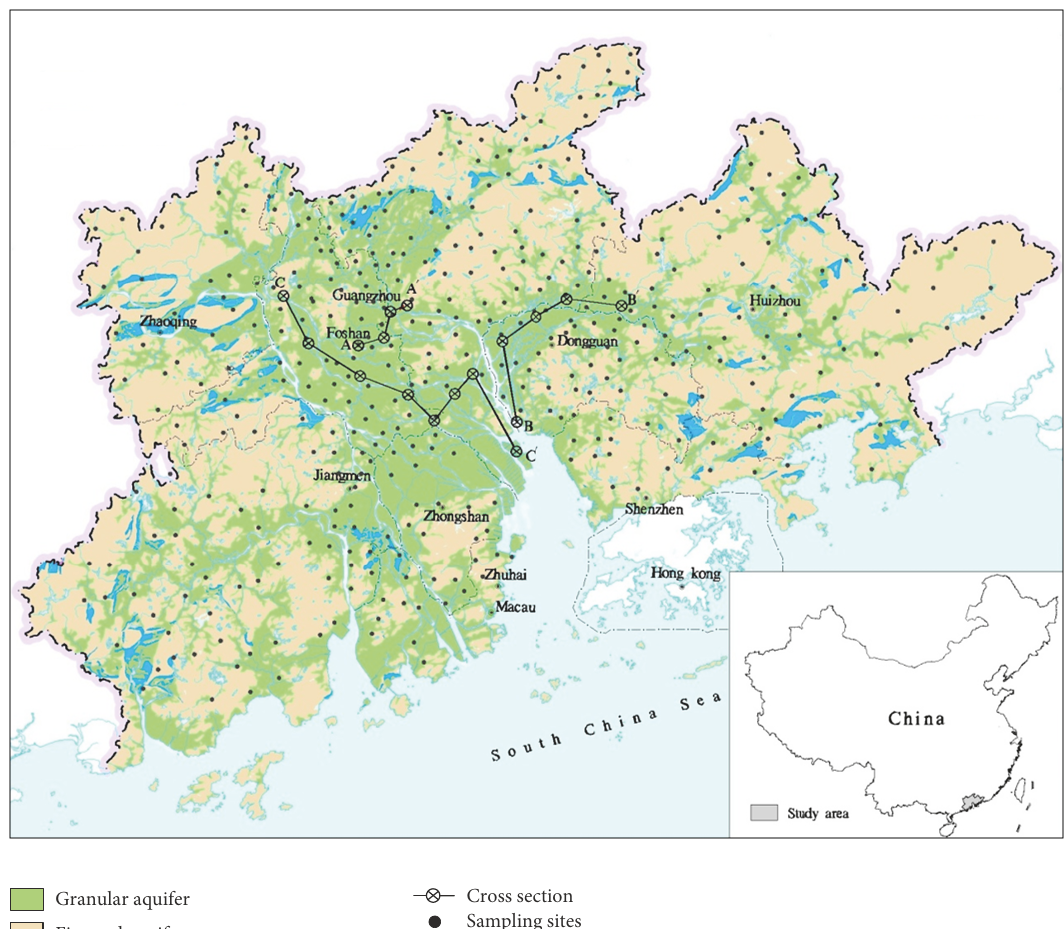
Figure 1: Hydrogeological setting and sampling sites in the